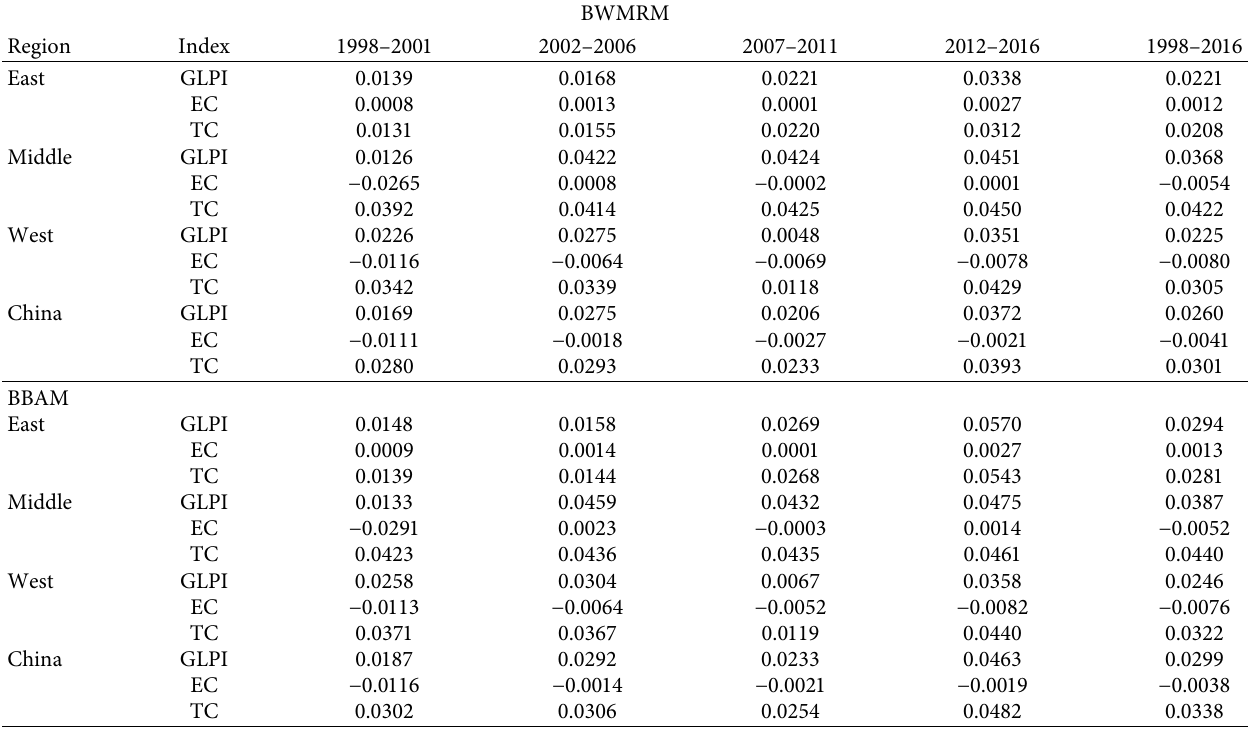
Table 3: The mean of GLPI and its